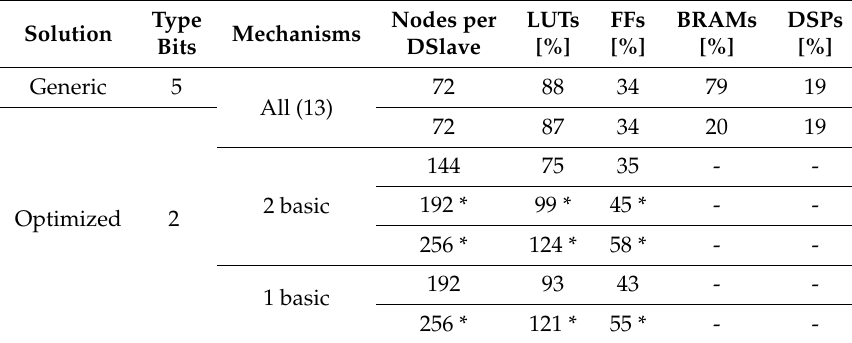
Table 4. Resource utilization for different molecular simulation variants (results marked with ’*’ correspond to unimplementable solutions—too many resources required or routing congestion problems